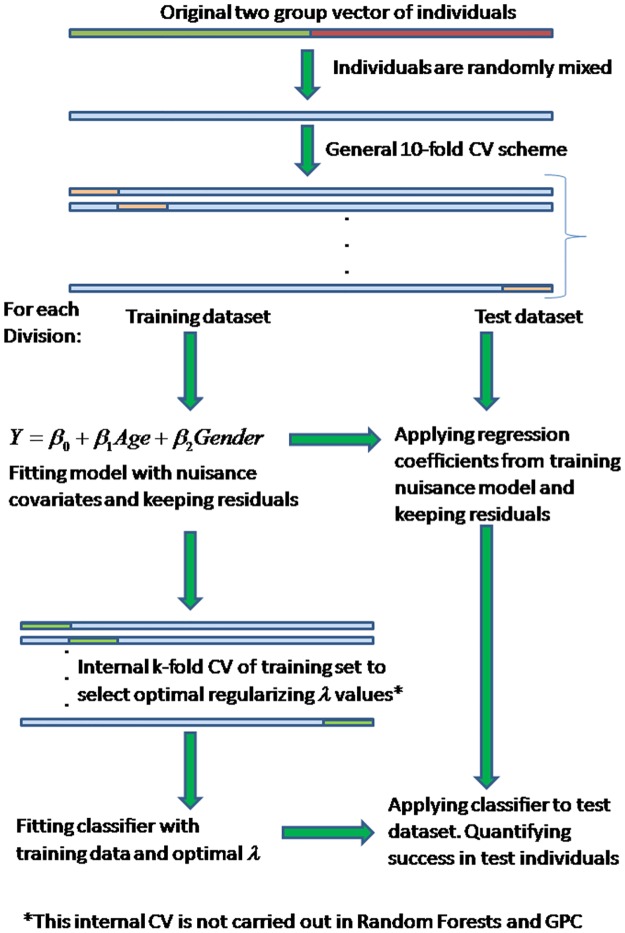
General cross validation scheme applied to evaluate the classification accuracy in all combinations of algorithms and data features.For most classifiers, cross-validation is used at two levels: at an outer level for training and testing and within each training sample to select the optimal values for the regularization parameters (delta). The effect of nuisance covariates on test data should be regressed out by using coefficients fitted in the training data. Individual performances are given as frequencies of test individuals successfully classified.